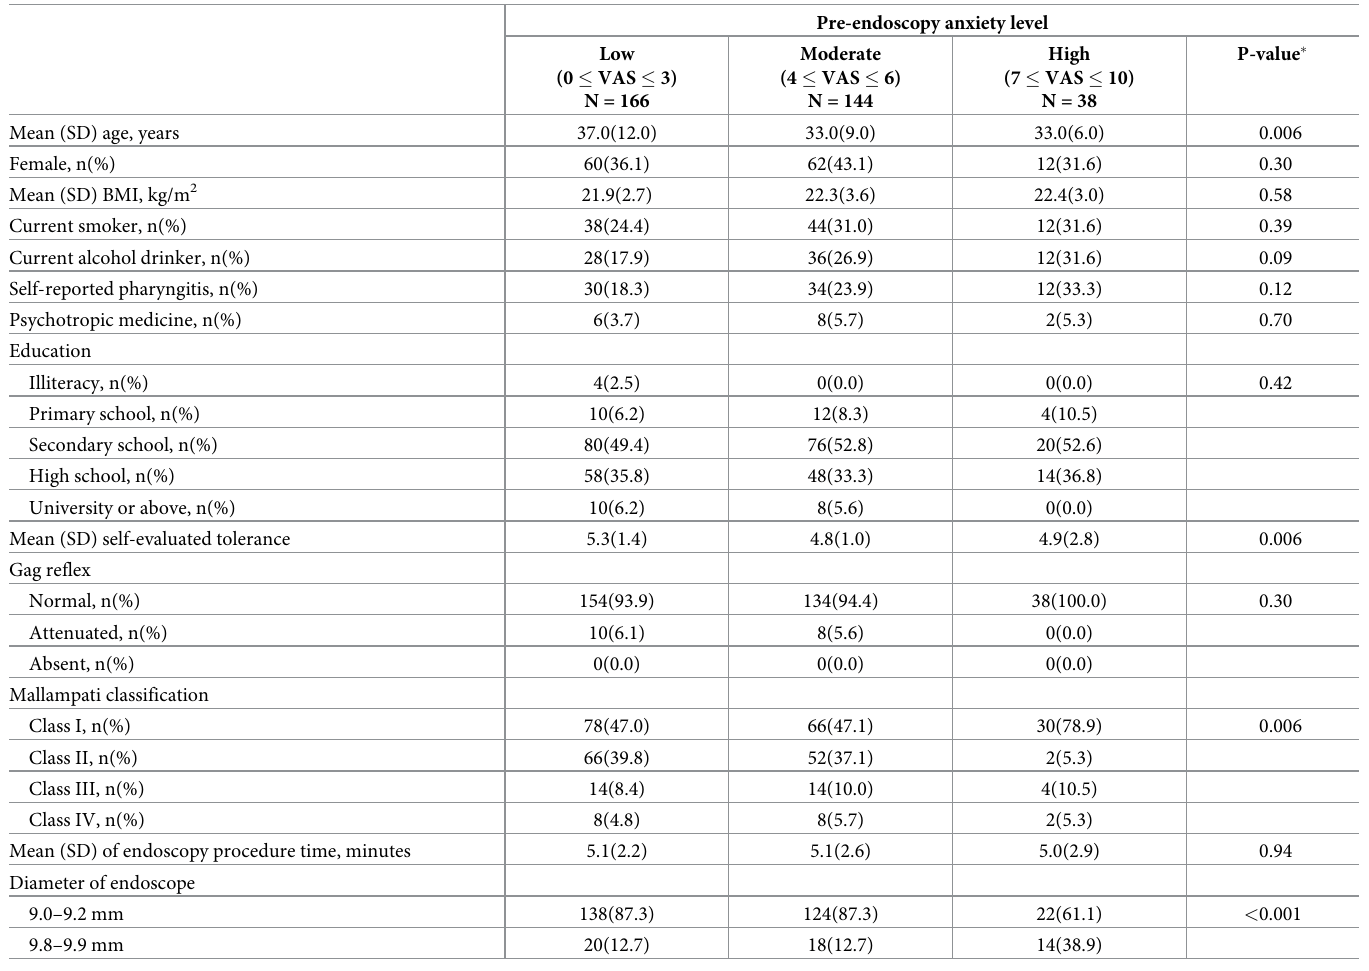
Table 1. Characteristics of